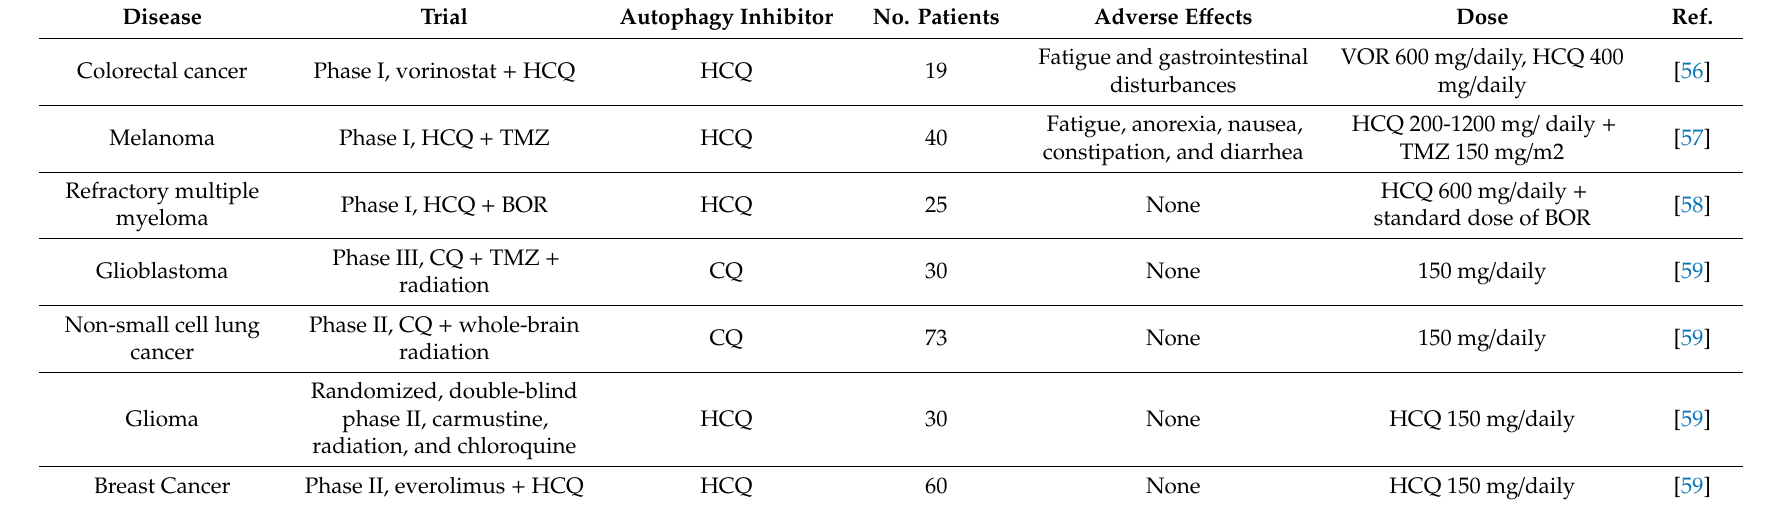
Table 2. Clinical trials involving hydroxychloroquine and chloroquine. CQ: chloroquine, HCQ: hydroxychloroquine, TMZ: temozolomide, VOR: